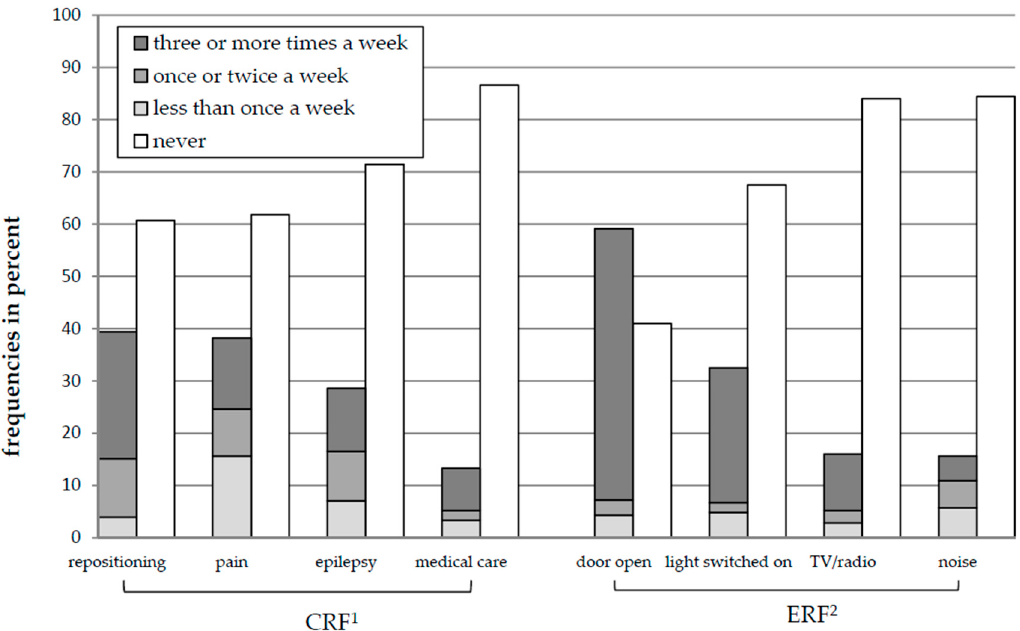
Figure 1. Frequencies of child-related factors (CRF) and environment-related factors (ERF). 1 answers